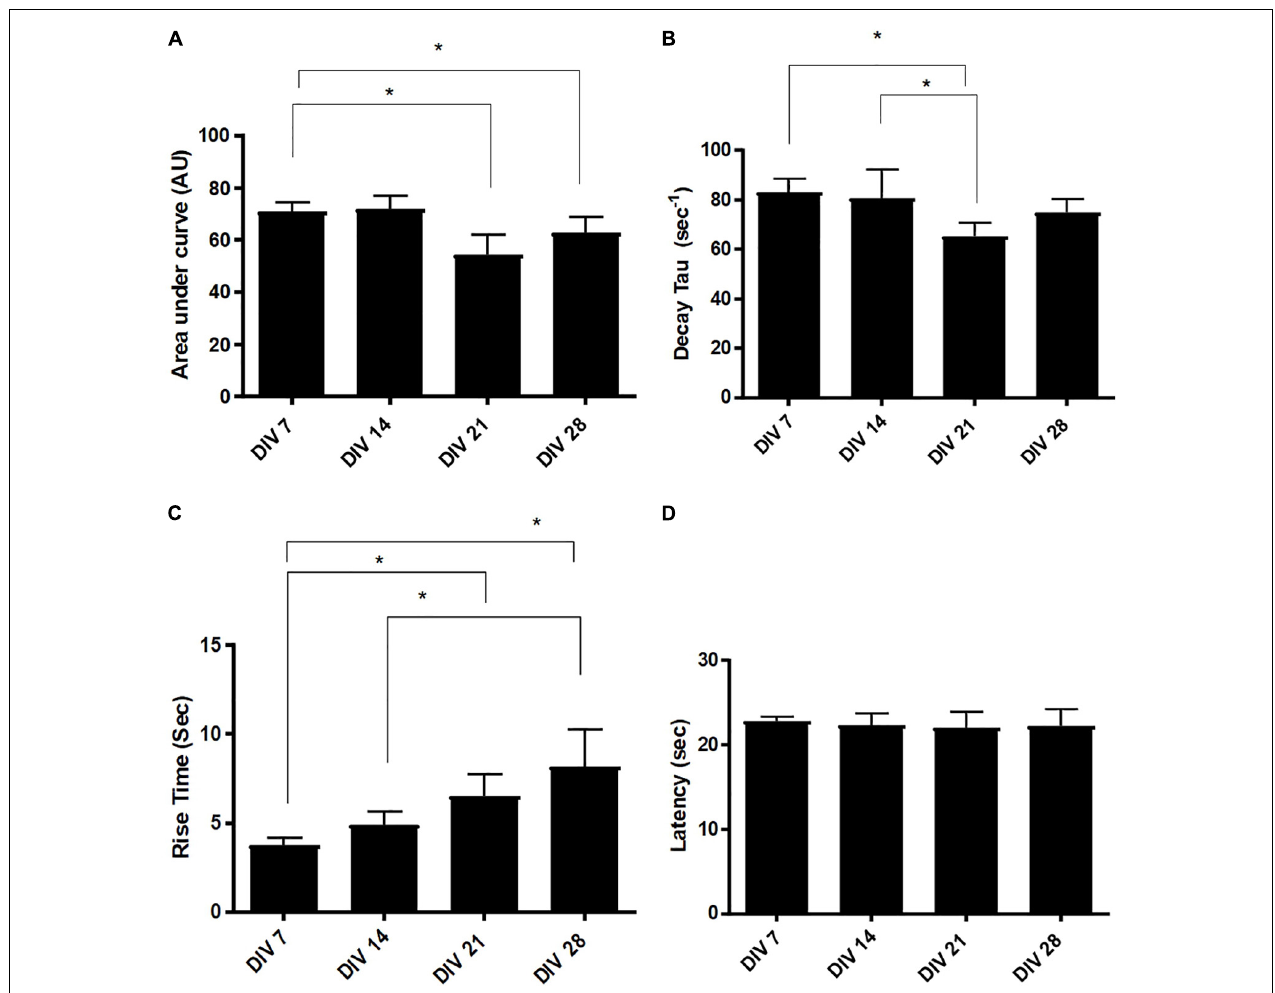
FIGURE 7 | Evolution of Ca 2 + transient parameters in mESC derived astrocytes. (A) Area under the curve (AUC), (B) decay tau (DT), (C) rise time (RT), and (D) latency. Statistical analysis reveals a significant increase in response RT from DIV7/14 to DIV 21 and DIV 28. Latency remains stable across different days in vitro (AU, arbitrary units, data expressed as mean ± SEM from three separate experiments, n = 30 astrocytes, ∗ P <